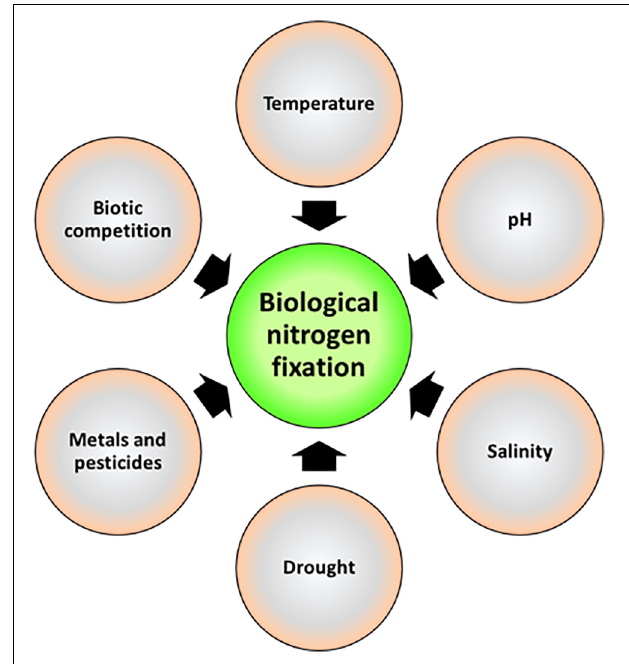
FIGURE 3 | Prominent factors affecting the symbiosis and efficiency of biological nitrogen